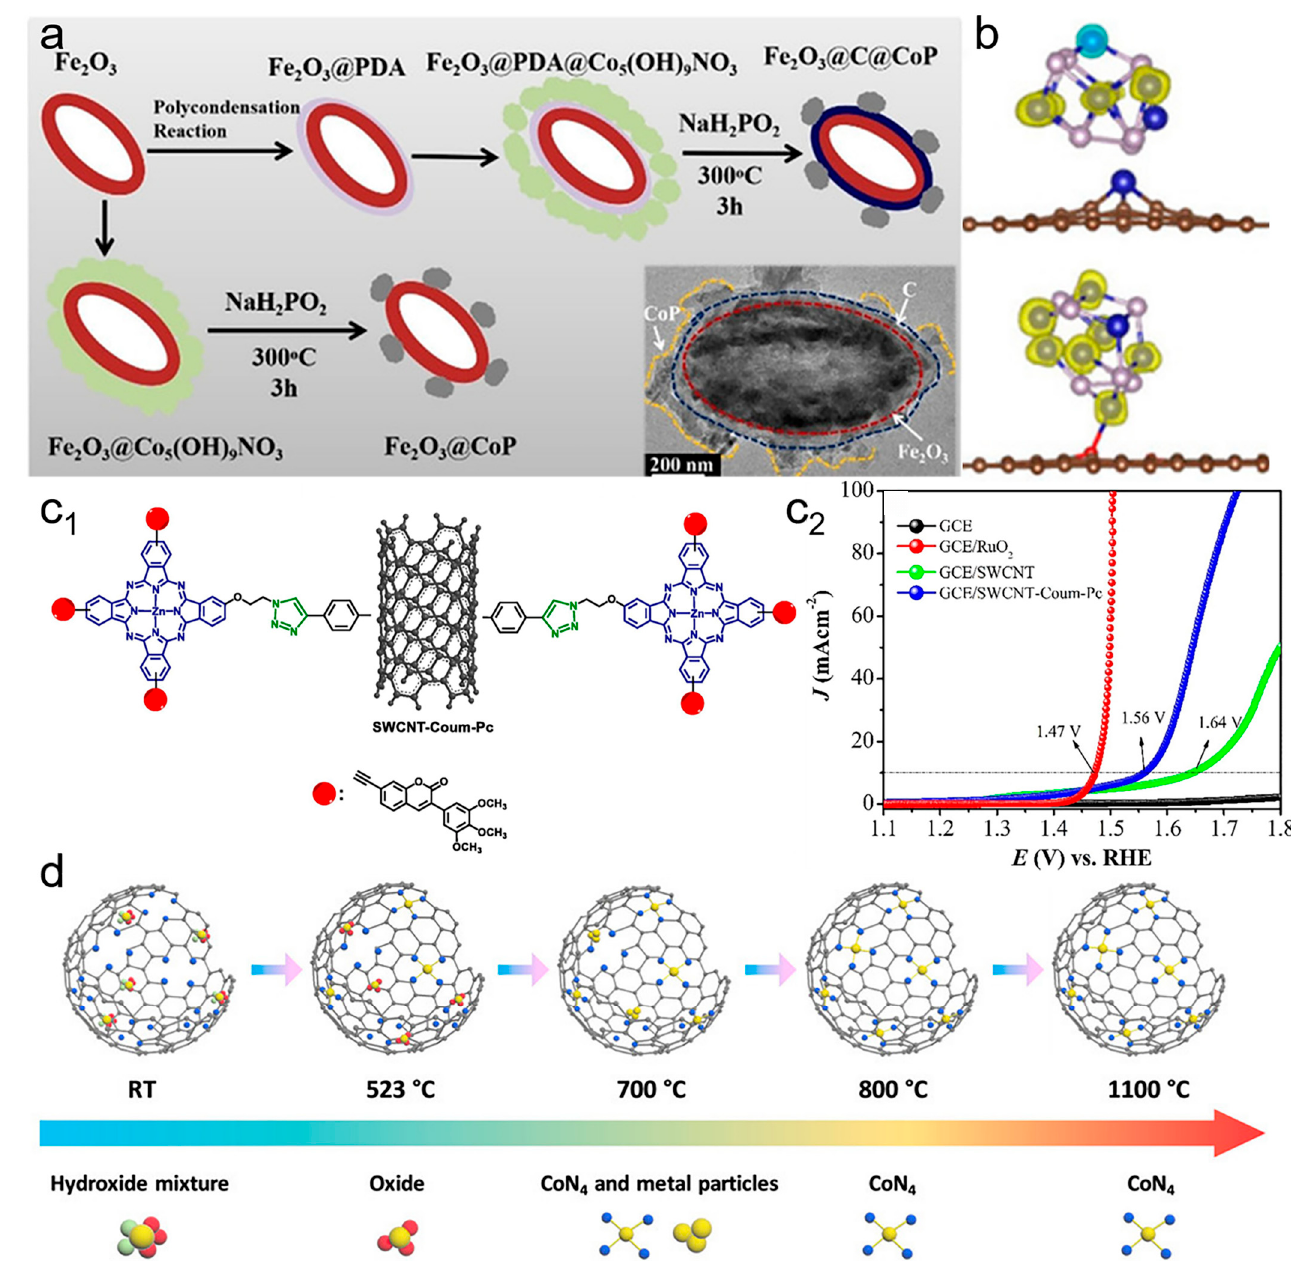
Figure 6. ( a ) Scheme for the fabrication of electrocatalysts. ( b ) Spin density of CoP/C and